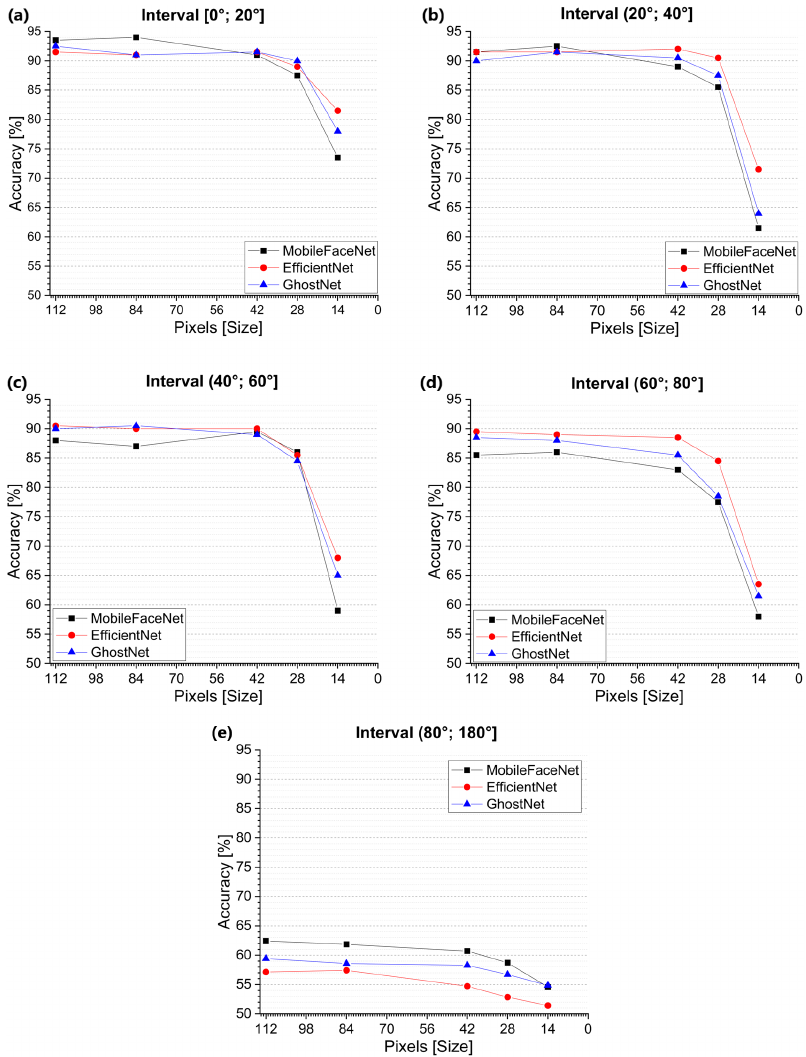
Figure 11. Plot results for each angle range with different resolution levels, where the following intervals are shown: ( a ) [ 0 ◦ ;20 ◦ ] , ( b ) [ 20 ◦ ;40 ◦ ] , ( c ) [ 40 ◦ ;60 ◦ ] , ( d ) [ 60 ◦ ;80 ◦ ] , and ( e ) [ 80 ◦ ;180 ◦ ] . Pixel resolutions of 14 × 14, 28 × 28, 42 × 42, 84 × 84, and 112 × 112 are used in all intervals. In summary, EfficientNet-B0 [11] is the best method for working with 14 × 14-pixel images in all of the different intervals, except for the [80 ◦ ;180 ◦ ] interval. MobileFaceNet [10] with image resolutions from 28 × 28 to 112 × 112 pixels proved to be the best method to work in the interval [80 ◦ ;180 ◦ ], where extreme rotations are found. Figure 12 shows examples of image pairs misclassified by MobileFaceNet, where we can qualitatively corroborate the challenges for each angle and resolution